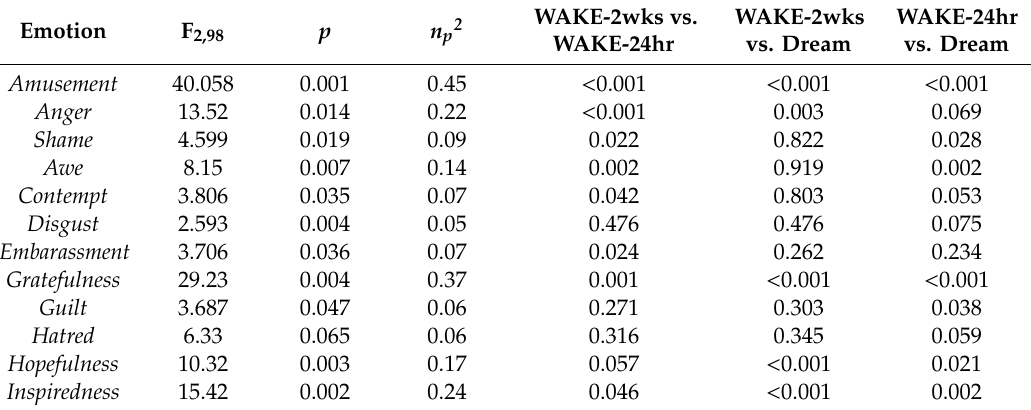
Table 2. Statistics of the repeated measures ANOVA on each